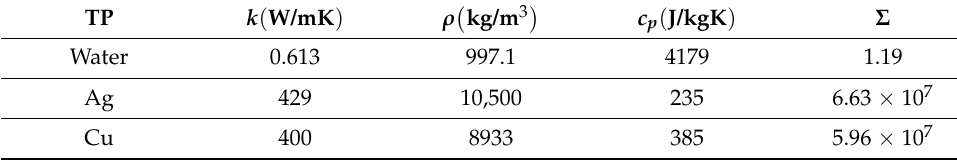
Table 1. Thermophysical properties (TP) of base fluids and nano-particles